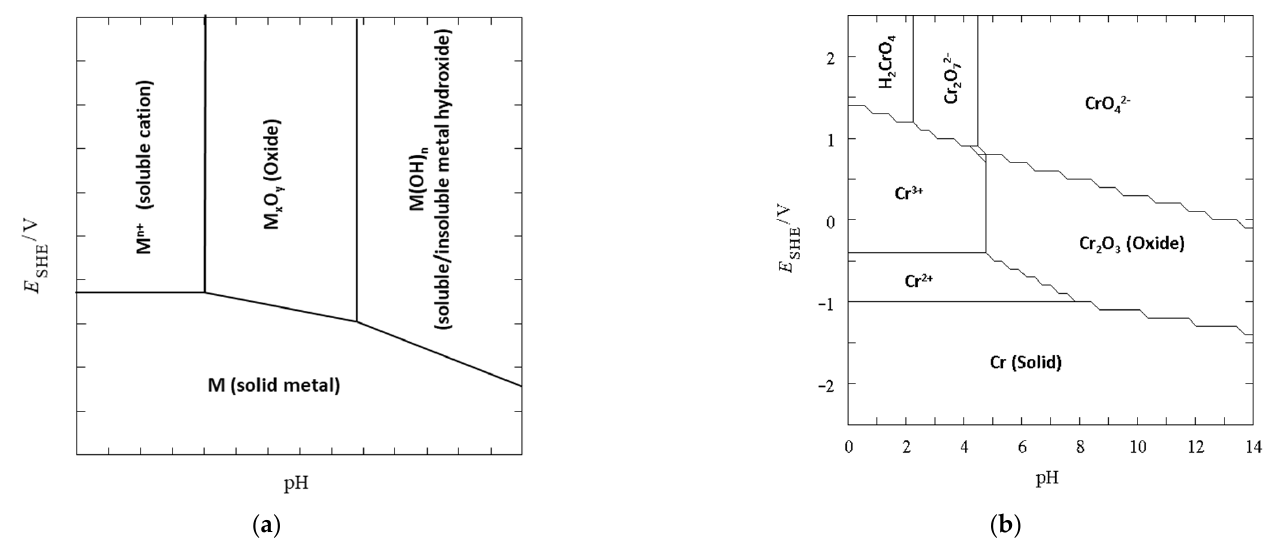
Figure 8. Pourbaix diagrams illustrating the speciation of ( a ) heavy metals, M, and ( b ) Cr in aqueous solutions. Other conditions that can alter the adsorption capacity of the heavy metal ions